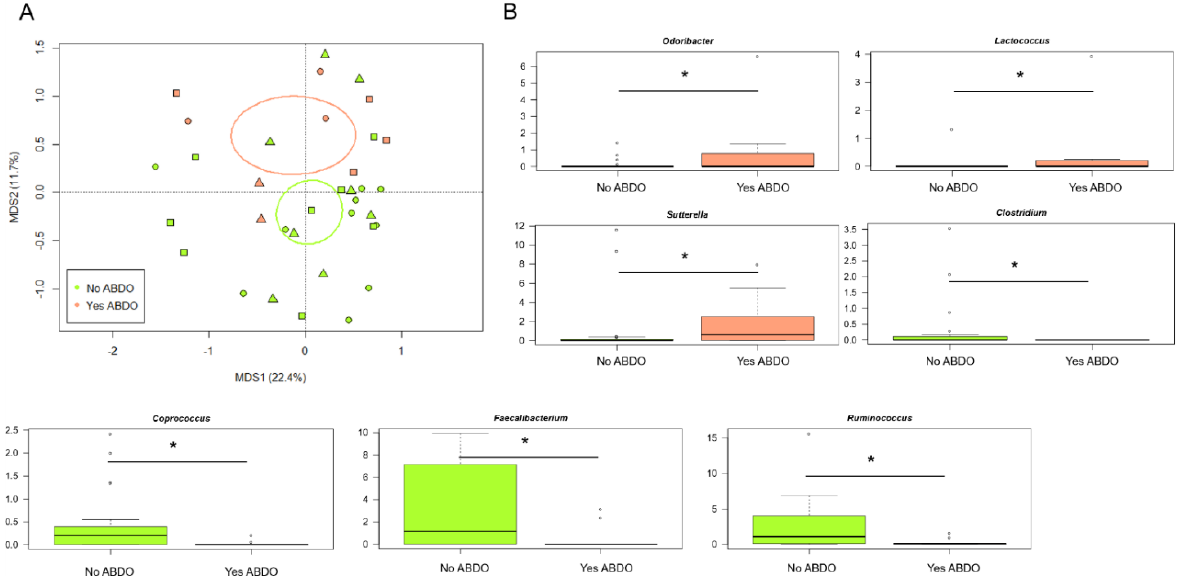
Figure 3. The gut microbiota profiles of patients with Kawasaki disease, Henoch–Schönlein purpura and non-KD febrile illness stratified by gastrointestinal involvement. ( A ) PCoA plot of beta diversity, based on Bray–Curtis dissimilarity between the genus-level profiles. A significant separation between patients with or without gastrointestinal involvement (ABDO 0 = no vs. ABDO 1 = yes) was found ( p = 0.05, permutation test with pseudo-F ratios). Ellipses include 95% confidence area based on the standard error of the weighted average of sample coordinates. ( B ) Boxplots showing the relative abundance distribution of bacterial genera significantly differentially represented between groups (* p ≤ 0.05, post-hoc Wilcoxon